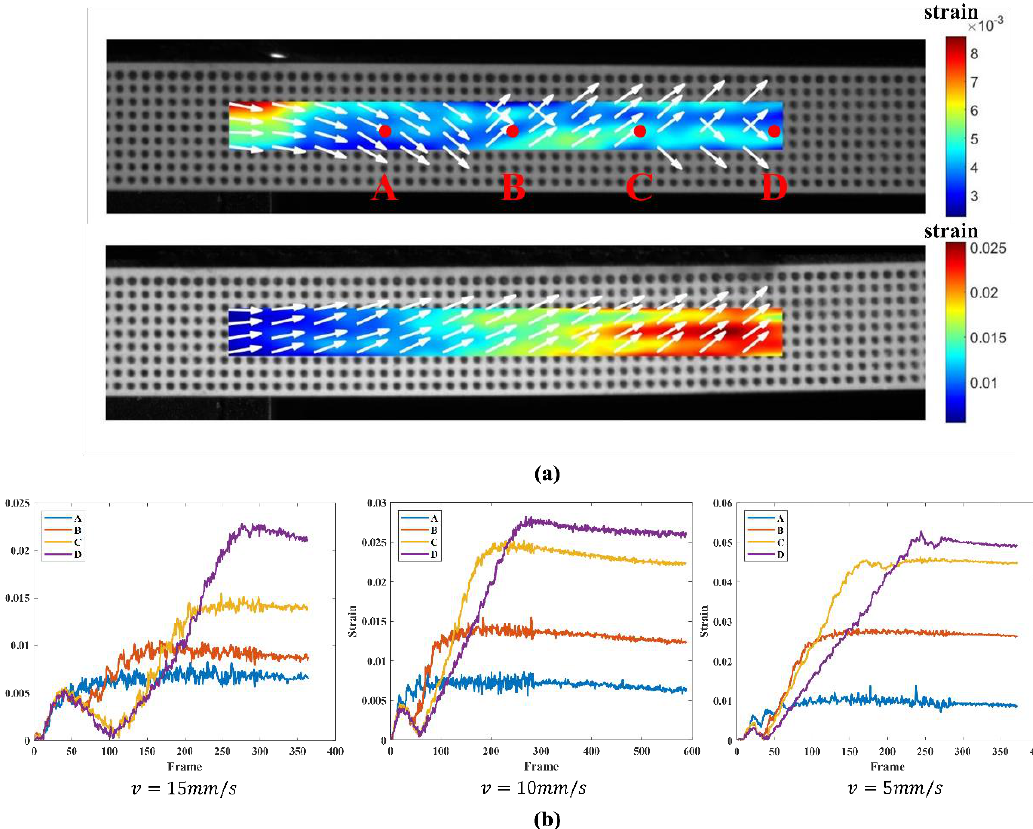
Figure 14. ( a ) The equivalent strain field at the beginning and the end of printing at 10 mm/s, and ( b ) variation curve of an equivalent strain at four points ABCD with